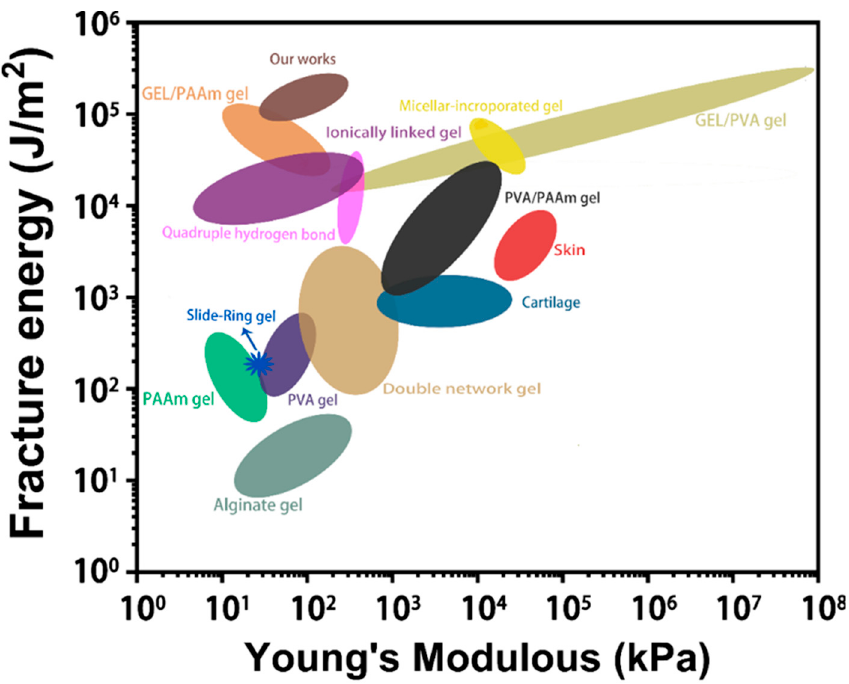
Figure 5. Comparisons of toughness of diverse structural models for dissipating energy